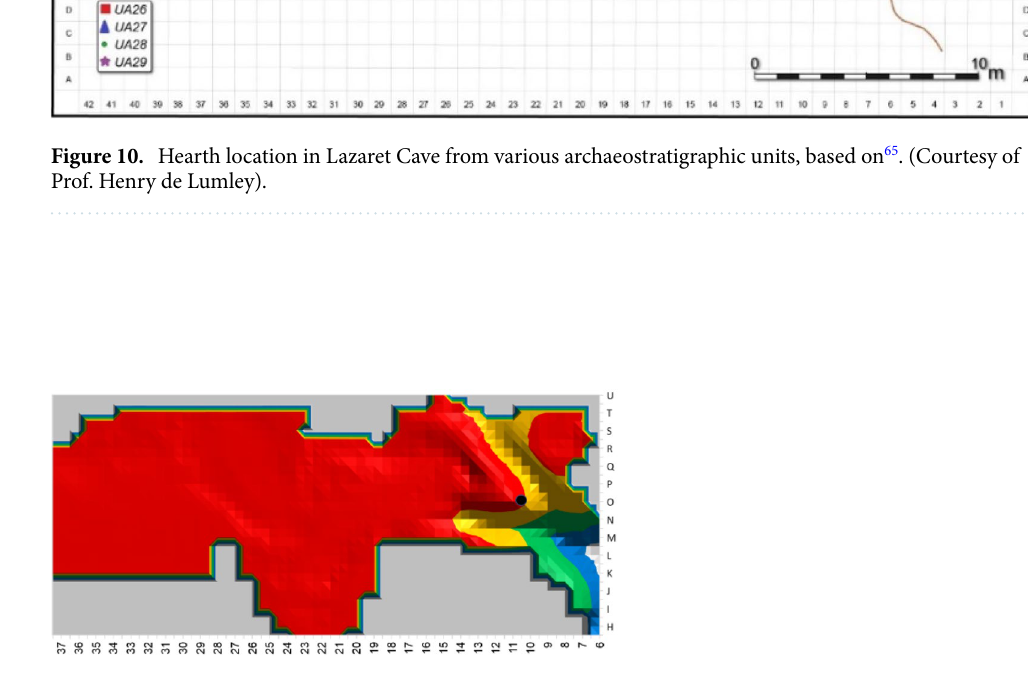
Figure 11. Simulation results for a small hearth at hearth location at H9 (black circle) with sensors at height 1.5 m. The green and blue zones are the long-duration occupation areas. The red zone is the non-occupational area. The yellow zone is short-duration occupation